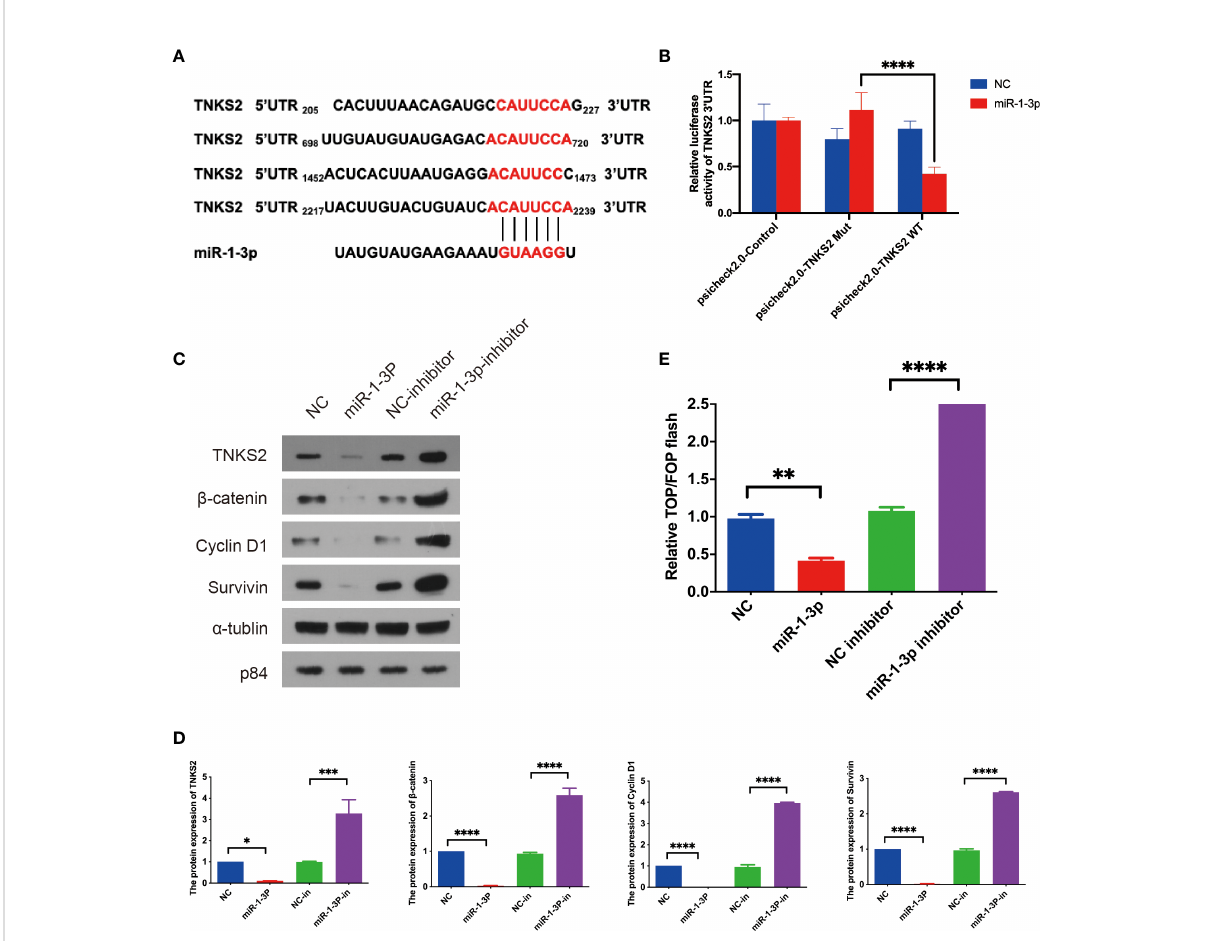
FIGURE 4 TNKS2 is the target of miR-1-3p as an activator of Wnt/ b -catenin signaling. (A) The binding sites of miR-1-3p in 3 ′ UTRs of TNKS2. (B) Luciferase activity of TNKS2 in 293T cells was negatively regulated by the miR-1-3p. Statistical analysis of the assay of three independent assays. (C, D) SKOV-3 cells were transfected with indicated miRNAs. The expression of b -catenin, Cyclin D1, and Survivin were detected with western blotting after 48-h treatment. Images are representative from three independent experiments. Statistical analysis of the western blotting result from three independent assay. (E) A 293T cells were transfected with the indicated miRNAs combined with TOP/FOP reporter plasmids for 36h before luciferase measurement. Cells transfected with the indicated miRNAs. Statistical analysis of the result from three independent assays, *p< 0.05, **p< 0.01, ***p< 0.001, ****p <